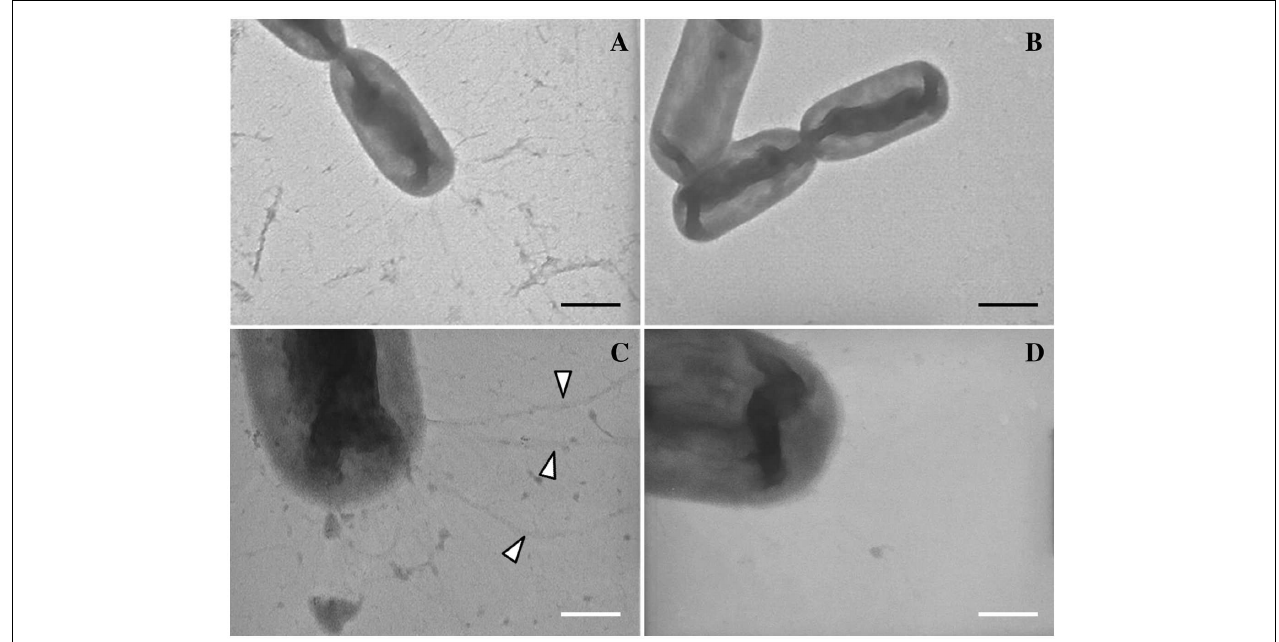
FIGURE 6 | Visualization of type IV pili of Lysobacter capsici AZ78 using Transmission Electron Microscopy (TEM). Pilus-like structures (arrows) emerge at the pole of L. capsici AZ78 cells grown on Pea Agar Medium amended with 0.5% Agar (w/v; A,C ) and these structures are absent in cells grown on Luria Bertani Agar amended with 0.5% Agar (w/v; B,D ). A and B, magnification X-19000, black bar 500 nm. (C,D) , magnification X-64000, white bar 150 nm.